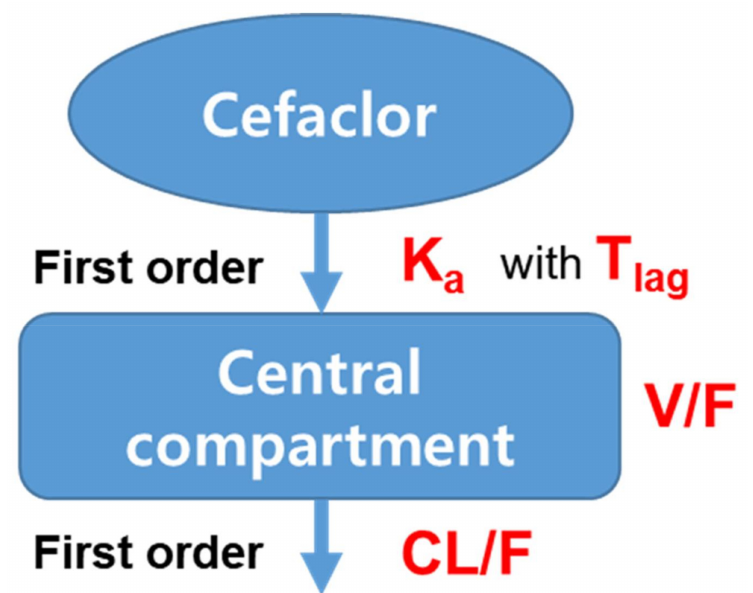
Figure 3. Population pharmacokinetic model structure of